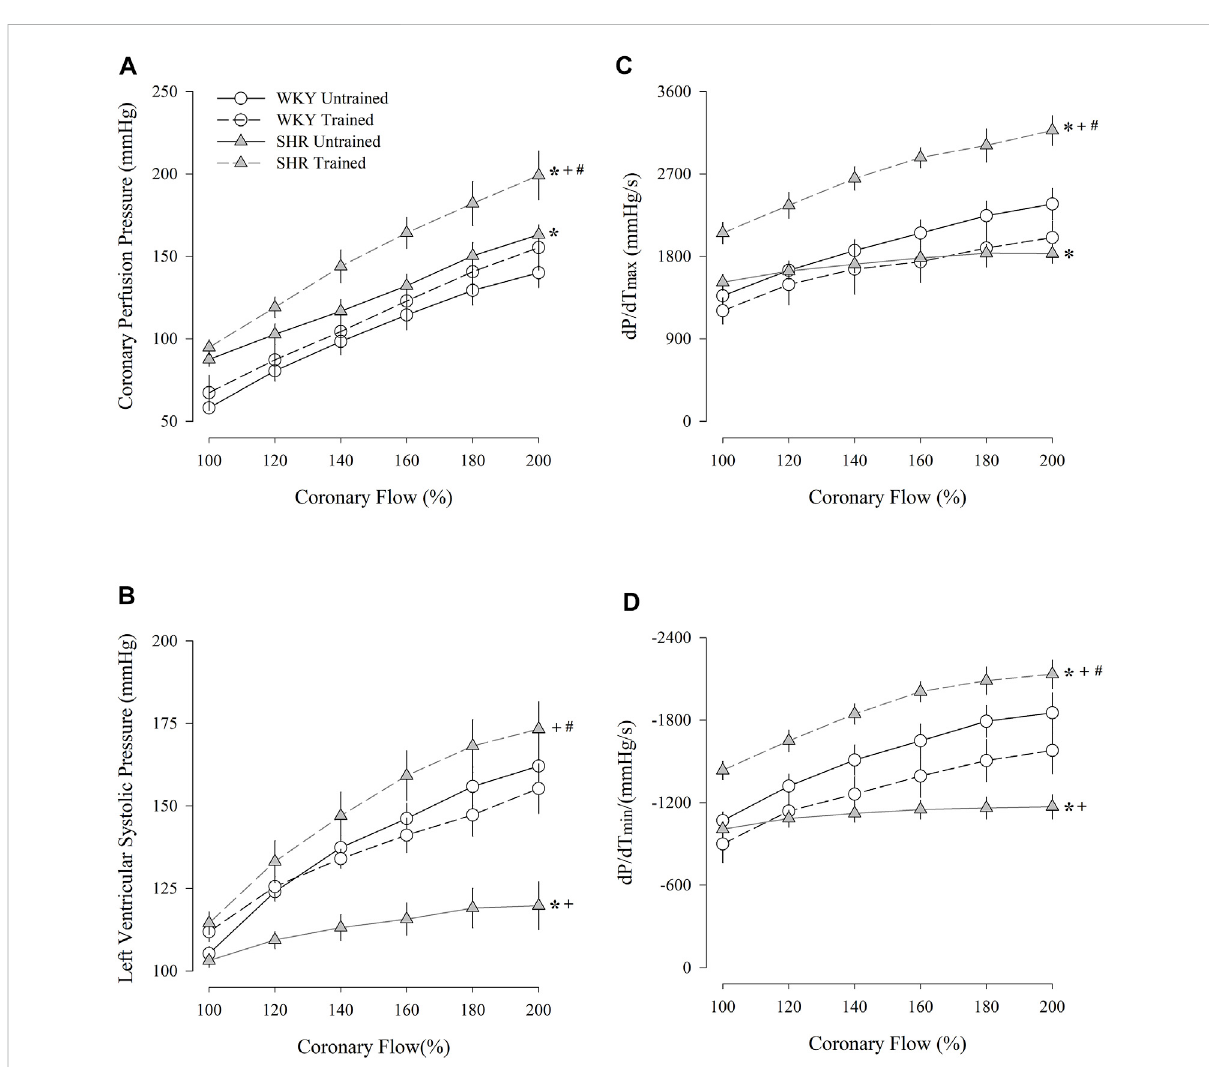
FIGURE 2 Coronary perfusion pressure (A) , left ventricular systolic pressure (B) , dP/dT (max) (C) , and dP/dT (min) (D) fl ow-induced in untrained ( N = 07) and trained ( N = 07) normotensive Wistar Kyoto (WKY) and hypertensive spontaneously rats (SHR). mmHg, millimeters of mercury; s, second; max, maximum;min;minimum.Valuesareexpressedasmeans±standarderrorofthemean.* p < 0.05vs.WKYuntrainedgroup; + p < 0.05vs.WKYtrained group; # p < 0.05 vs. SHR untrained